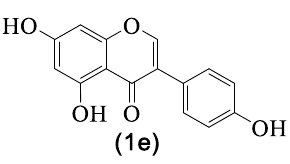
Figure 5. Genistein 1e structure.